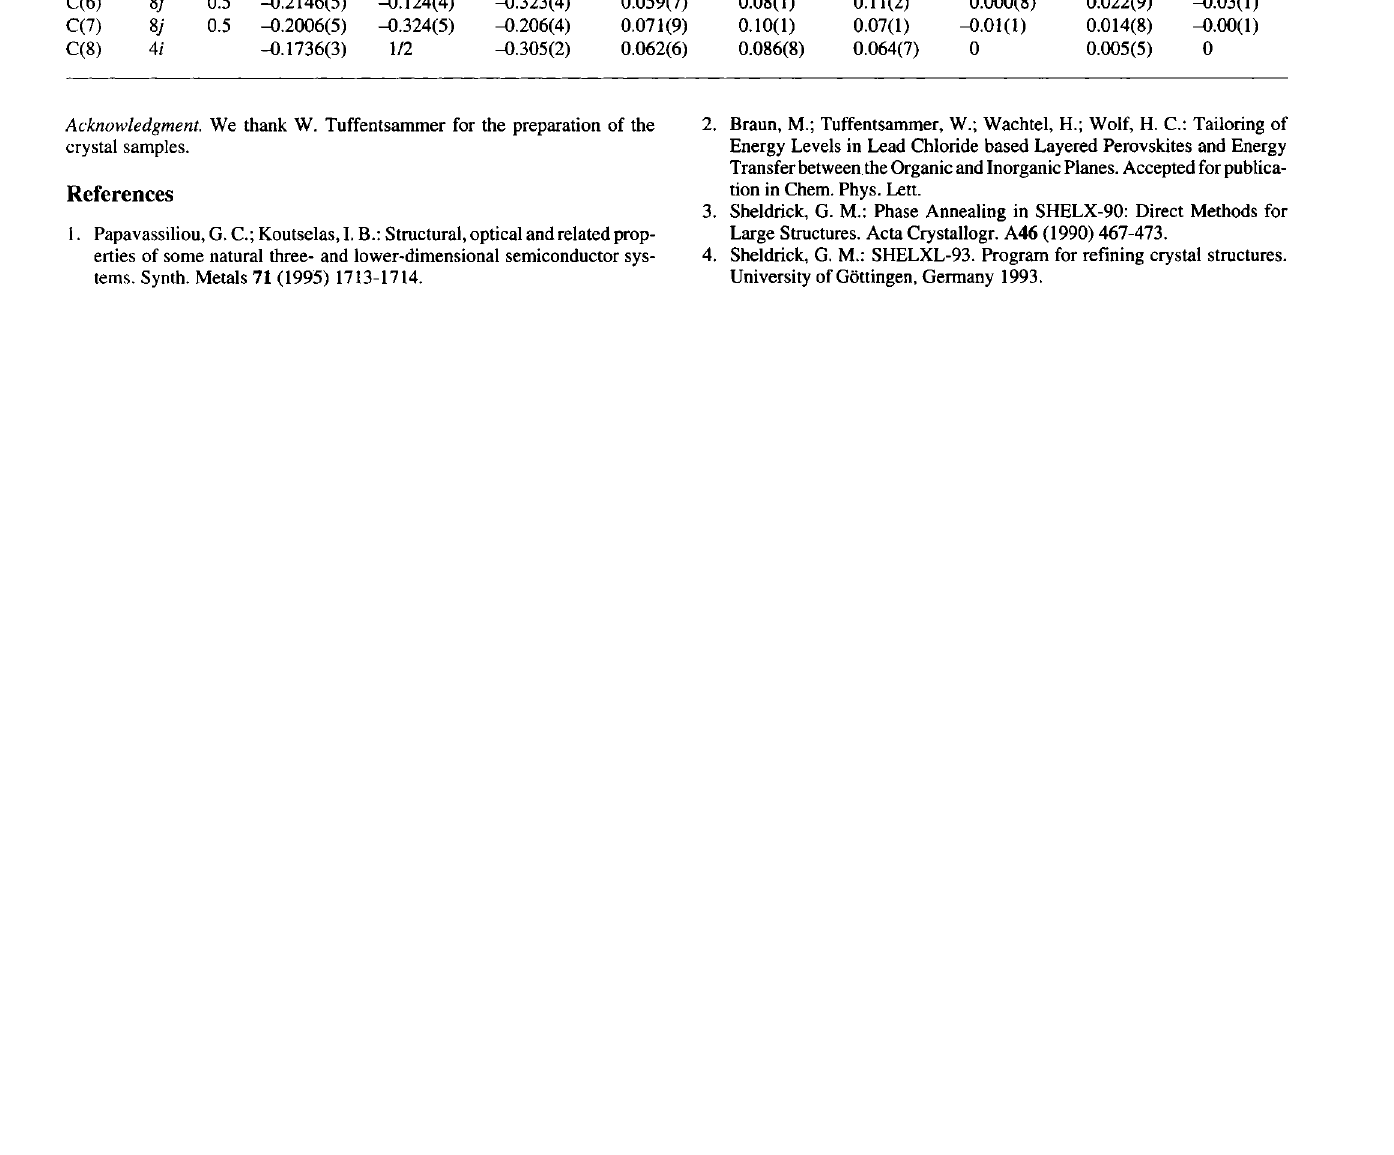
Table 3. Atomic coordinates and displacement parameters (in Â 2